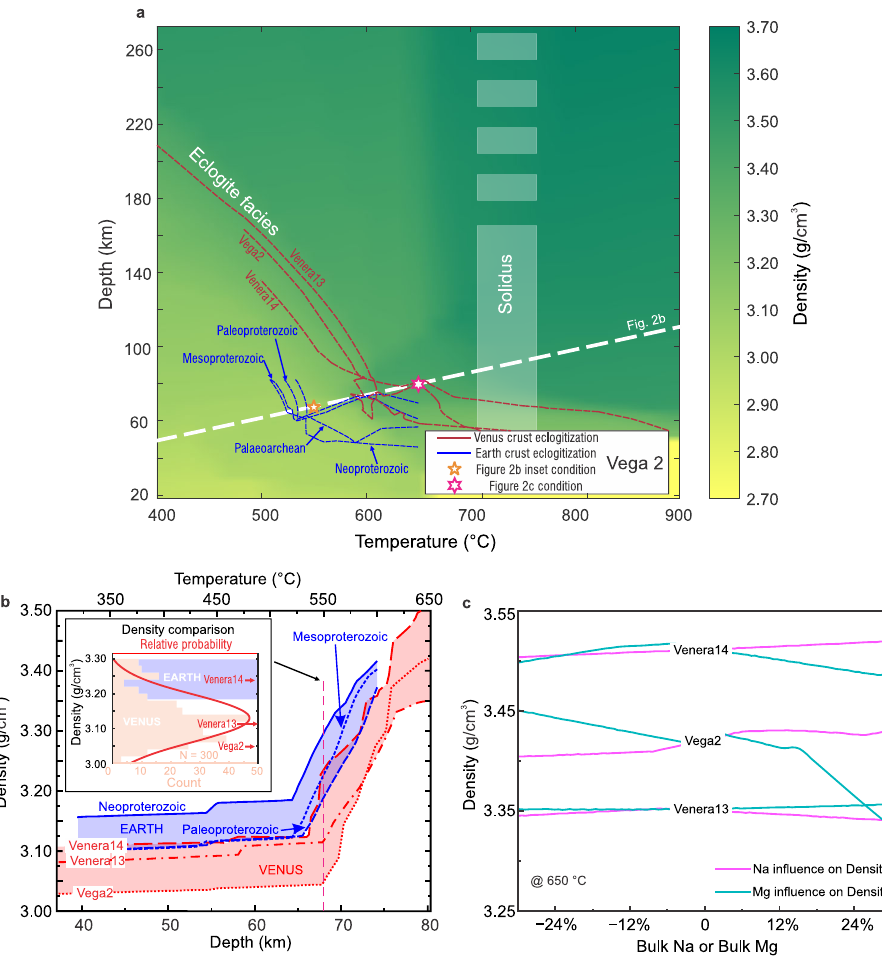
Fig. 2 | Modeled densities of slab crusts. a P – T density map in the range 400 – 900°C, 20 – 270km, calculated for Vega 2 composition (Supplementary Table 2). The corresponding phase diagram is presented in Supplementary Fig. 1. The blue and red dash lines display the P – T boundaries of eclogite facies in Earth ’ s and Venus ’ crusts. The white area at 700 – 750°C broadly denotes the solidus of metabasites 38 – 41 . The bright yellow colors represent low densities, and dark green